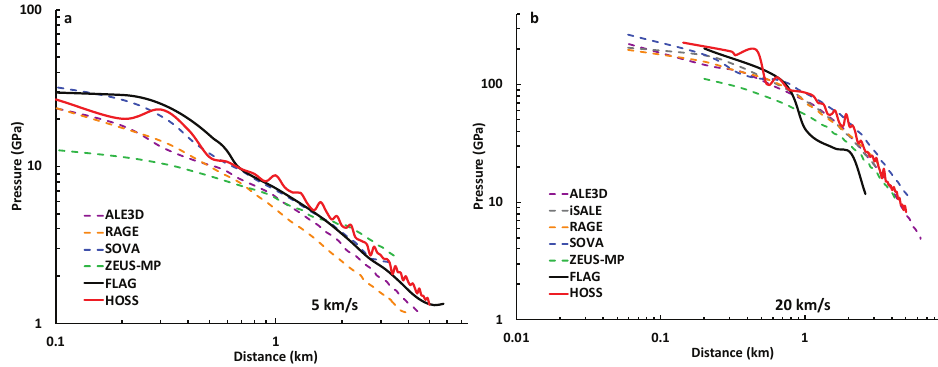
Figure 10. 3D oblique impact (45 ◦ from vertical), vertical tracers from FLAG and HOSS simulations, plotted with data from Pierazzo et al. [5] for ( a ) 5 km/s impact and ( b ) 20 km/s impact.